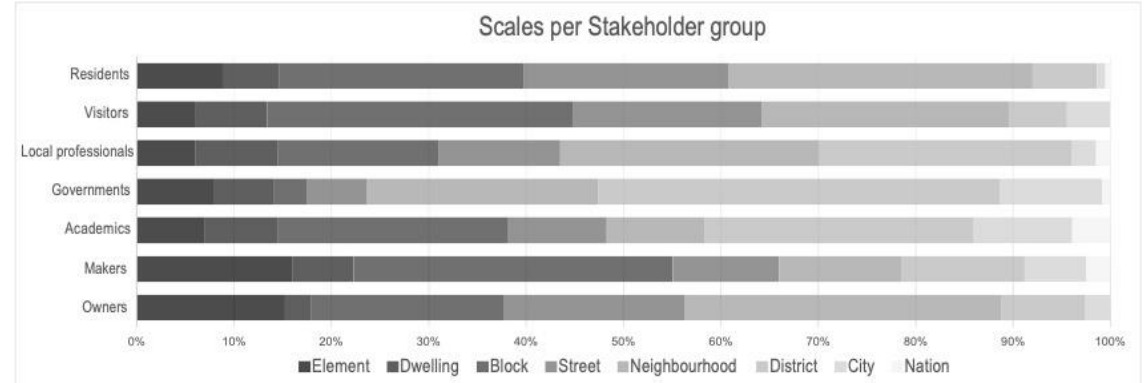
Figure 6. Scale levels mentioned per stakeholder group. The chart shows scale levels as a percentage of the total of quotations of a stakeholder group. Table 3. Majority and minority reports per stakeholder group illustrating the aggregate and deviating evaluations per